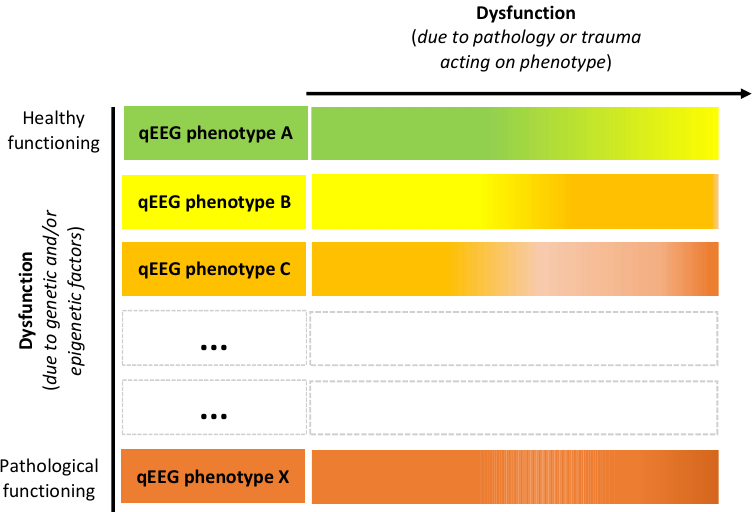
Figure 3. Schematic illustration of qEEG phenotypes’ diversity and relative dynamism. Horizontal arrow indicates that every qEEG phenotype may exhibit changes, to some extent, within its own qEEG oscillatory pattern due to pathology, brain development dynamics, or trauma.